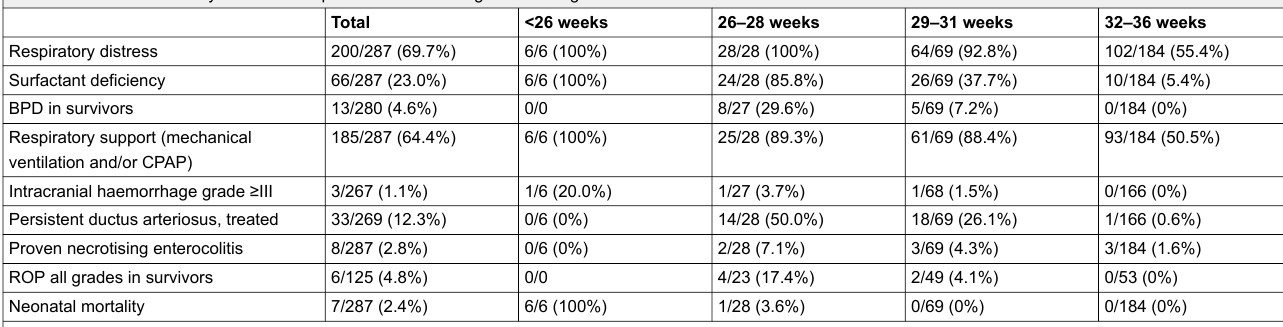
Table 2: Neonatal morbidity in live born triplets related to their gestational age.